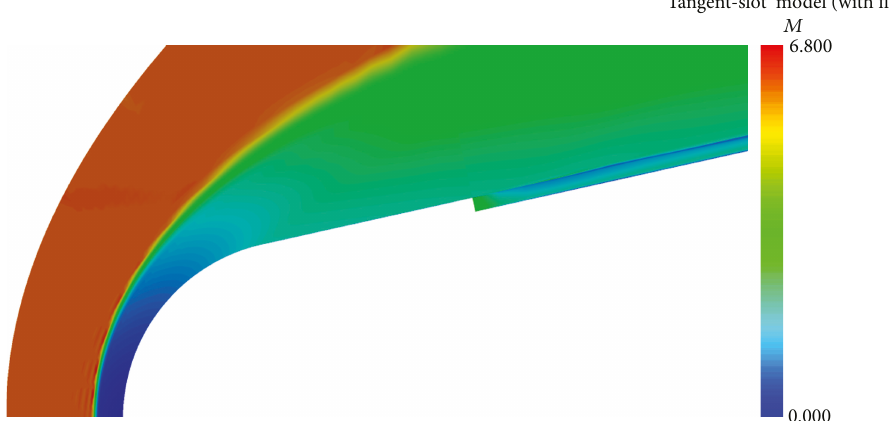
Figure 22: Tangent-slot model Mach number distribution, mass fl ow 0.55 kg/S, Re = 4 3 × 10 6 , α = 0 0 ° , M = 6 8